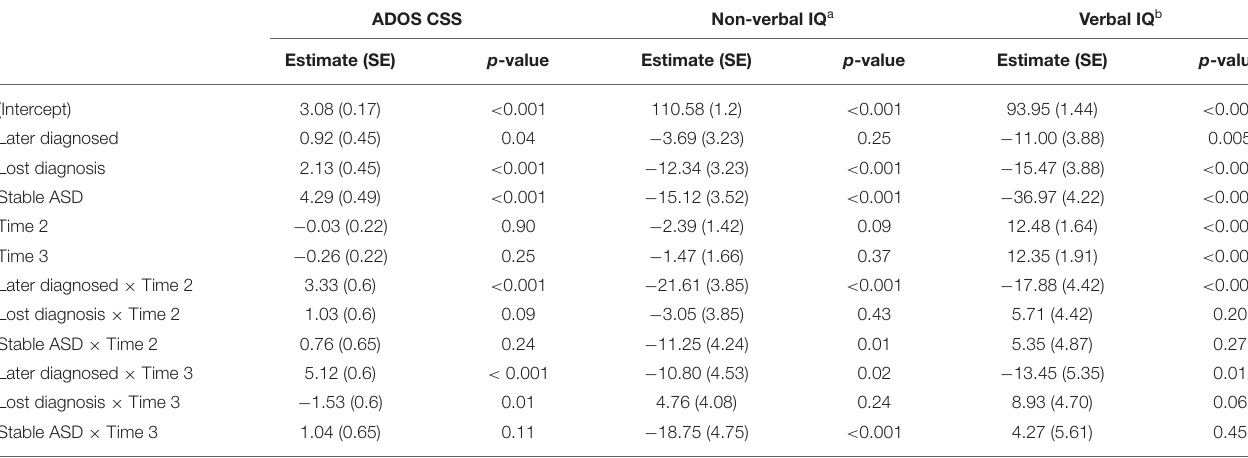
TABLE 4 | Parameter Estimates (SE) for linear mixed-effects models examining developmental trajectories of autism symptom severity, as well as non-verbal and verbal IQ. ADOS